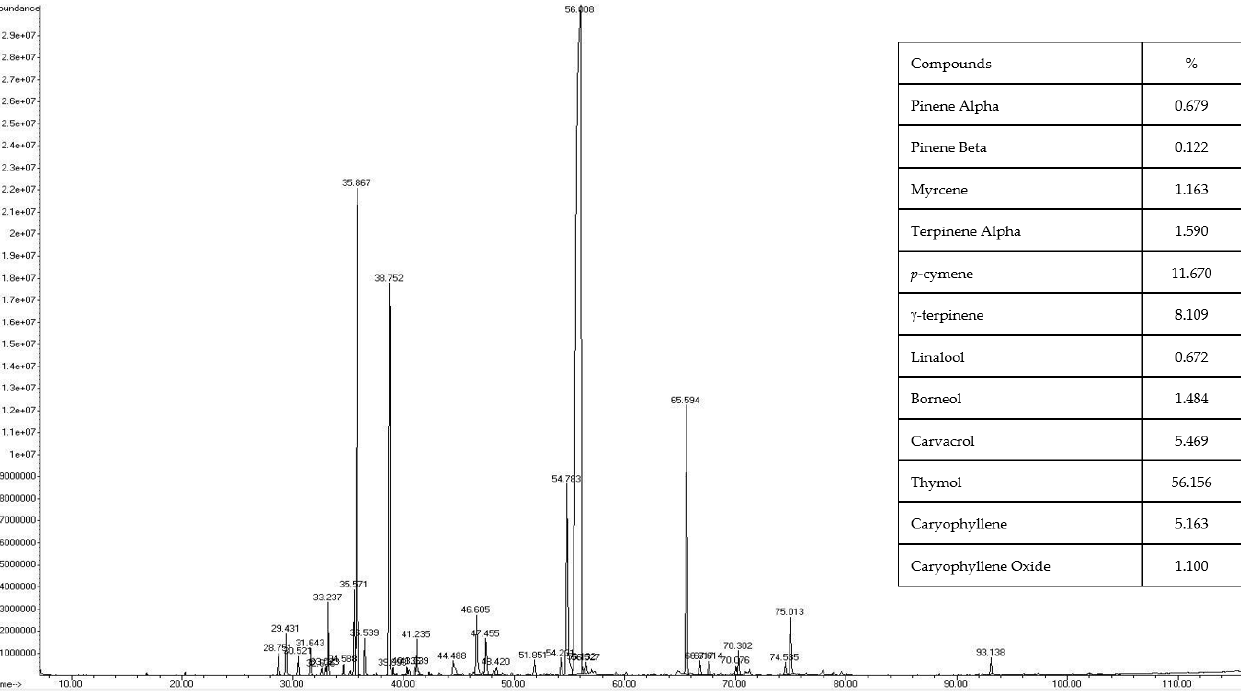
Figure 2. Thyme essential oil chromatogram by GS/MS/MS.